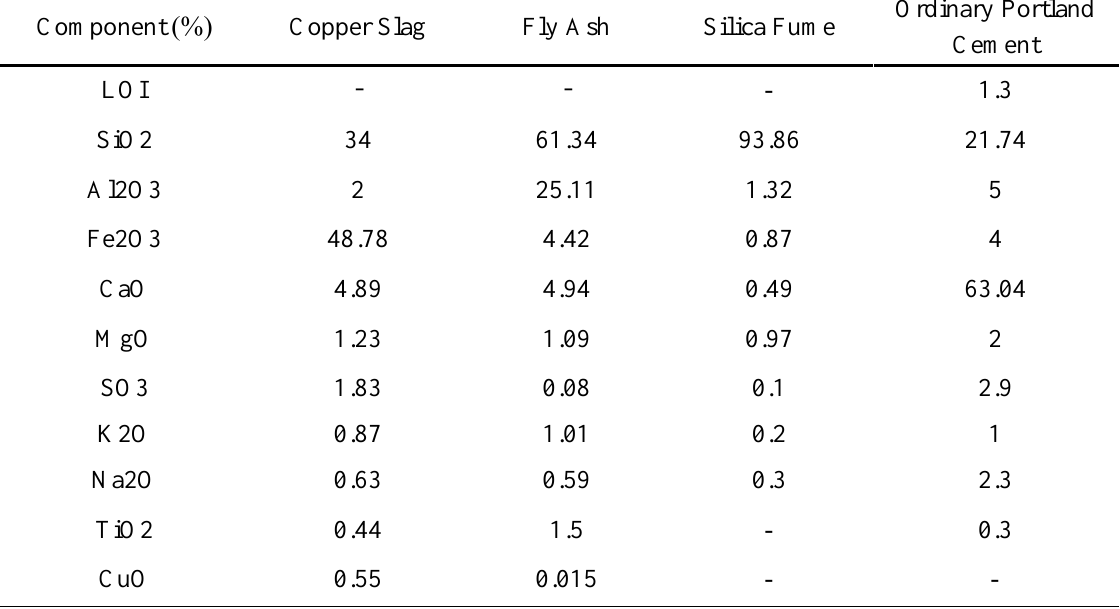
Table 1. Chemical properties of copper slag, fly ash, silica fume and ordinary Portland